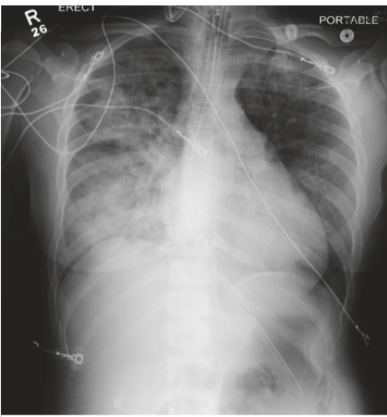
Figure 1: Chest X-ray: pulmonary edema with predominant right side opacities.